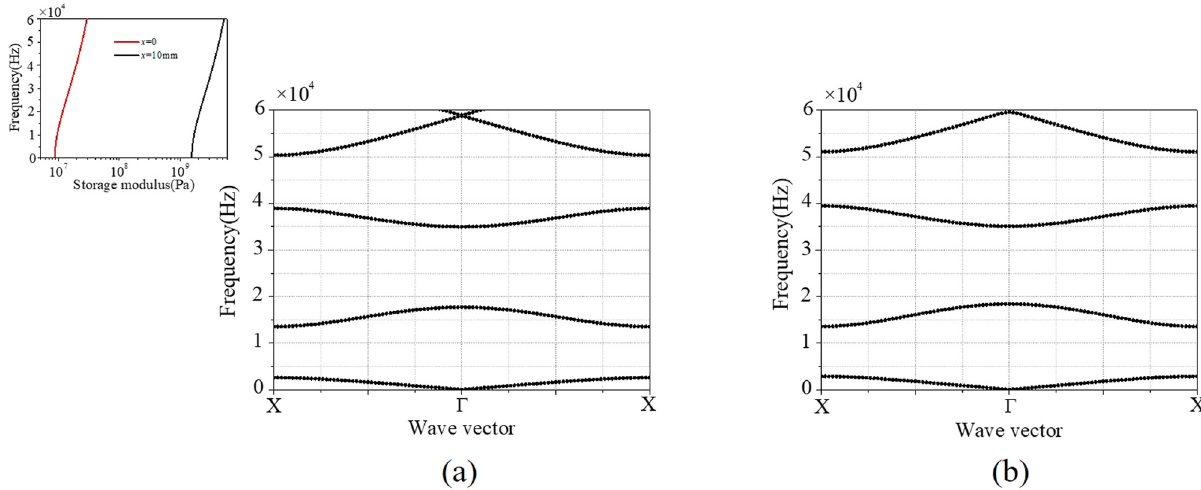
Figure 4: Band gaps of two oblique incident SH - waves: ( a ) 45° and ( b ) 60°.